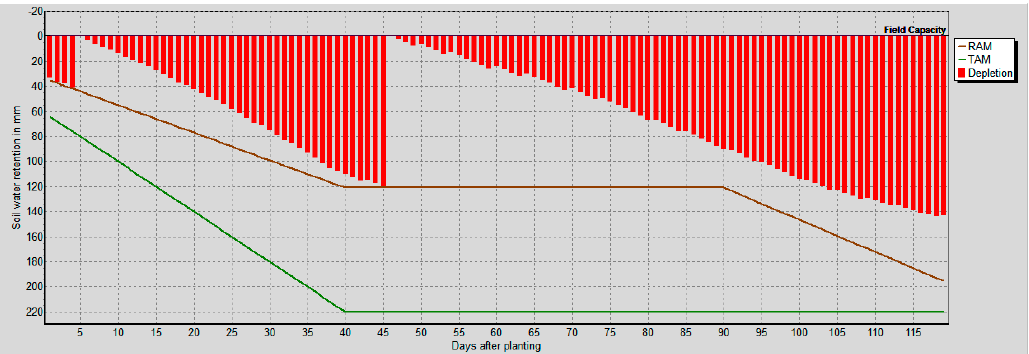
Figure 3. Irrigation schedules for barley.